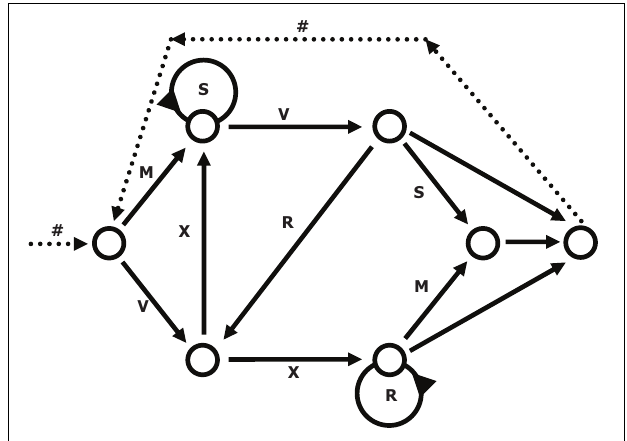
FIGURE 1 | The transition graph representation of the grammar used in the experiment (cf., Reber, 1967).